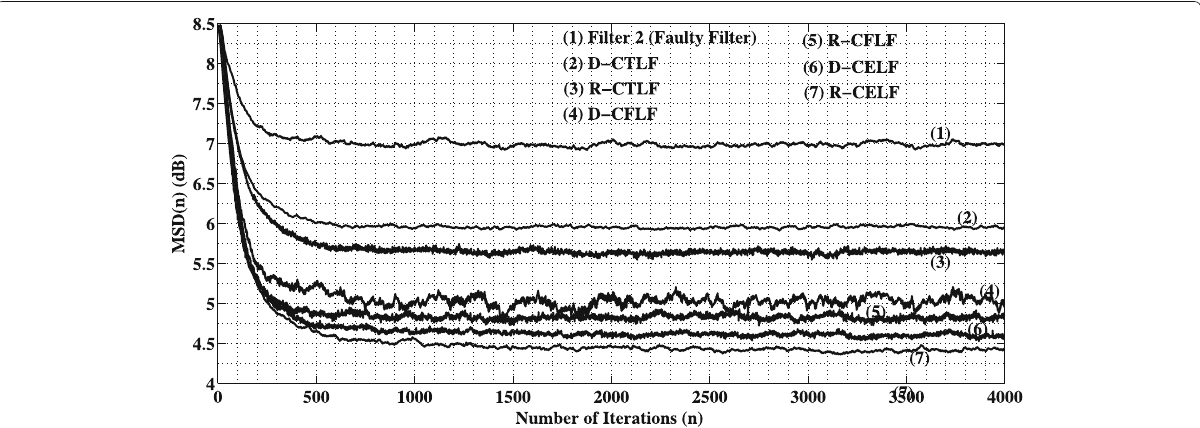
Fig. 10 MSD comparison for different numbers of combining filters under faulty operating conditions when input signal is white noise